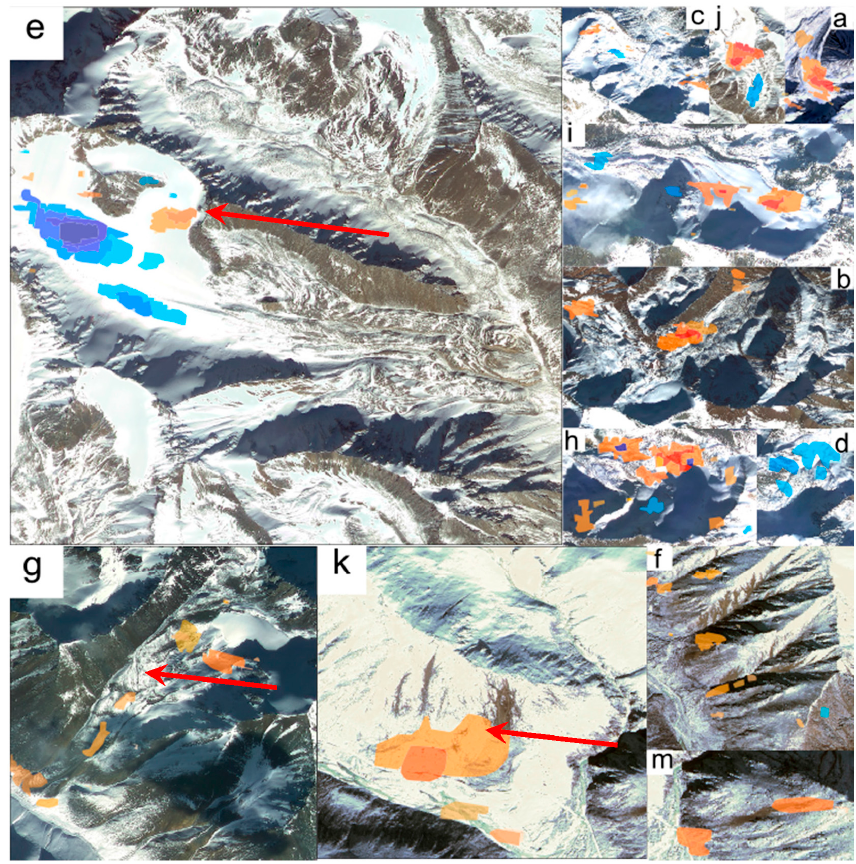
Figure 8. Gaofen-1 optical images acquired after the earthquake demonstrate the movements of the corresponding detected area; the radar line of sight is marked with the red arrows.